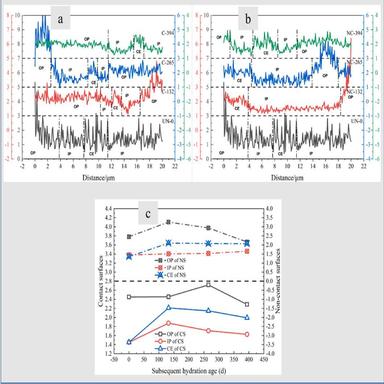
Change curve of the C/S ratio for different samples: (a) CS; (b) NS; (c) C/S ratio results for different phases.